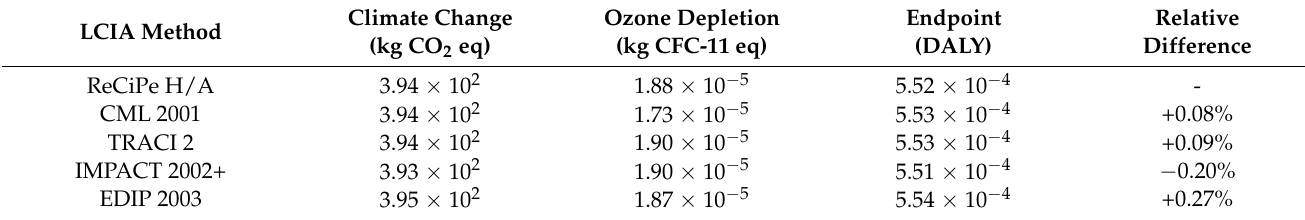
Table 5. Midpoint and endpoint indicators obtained using various life cycle impact assessment (LCIA)